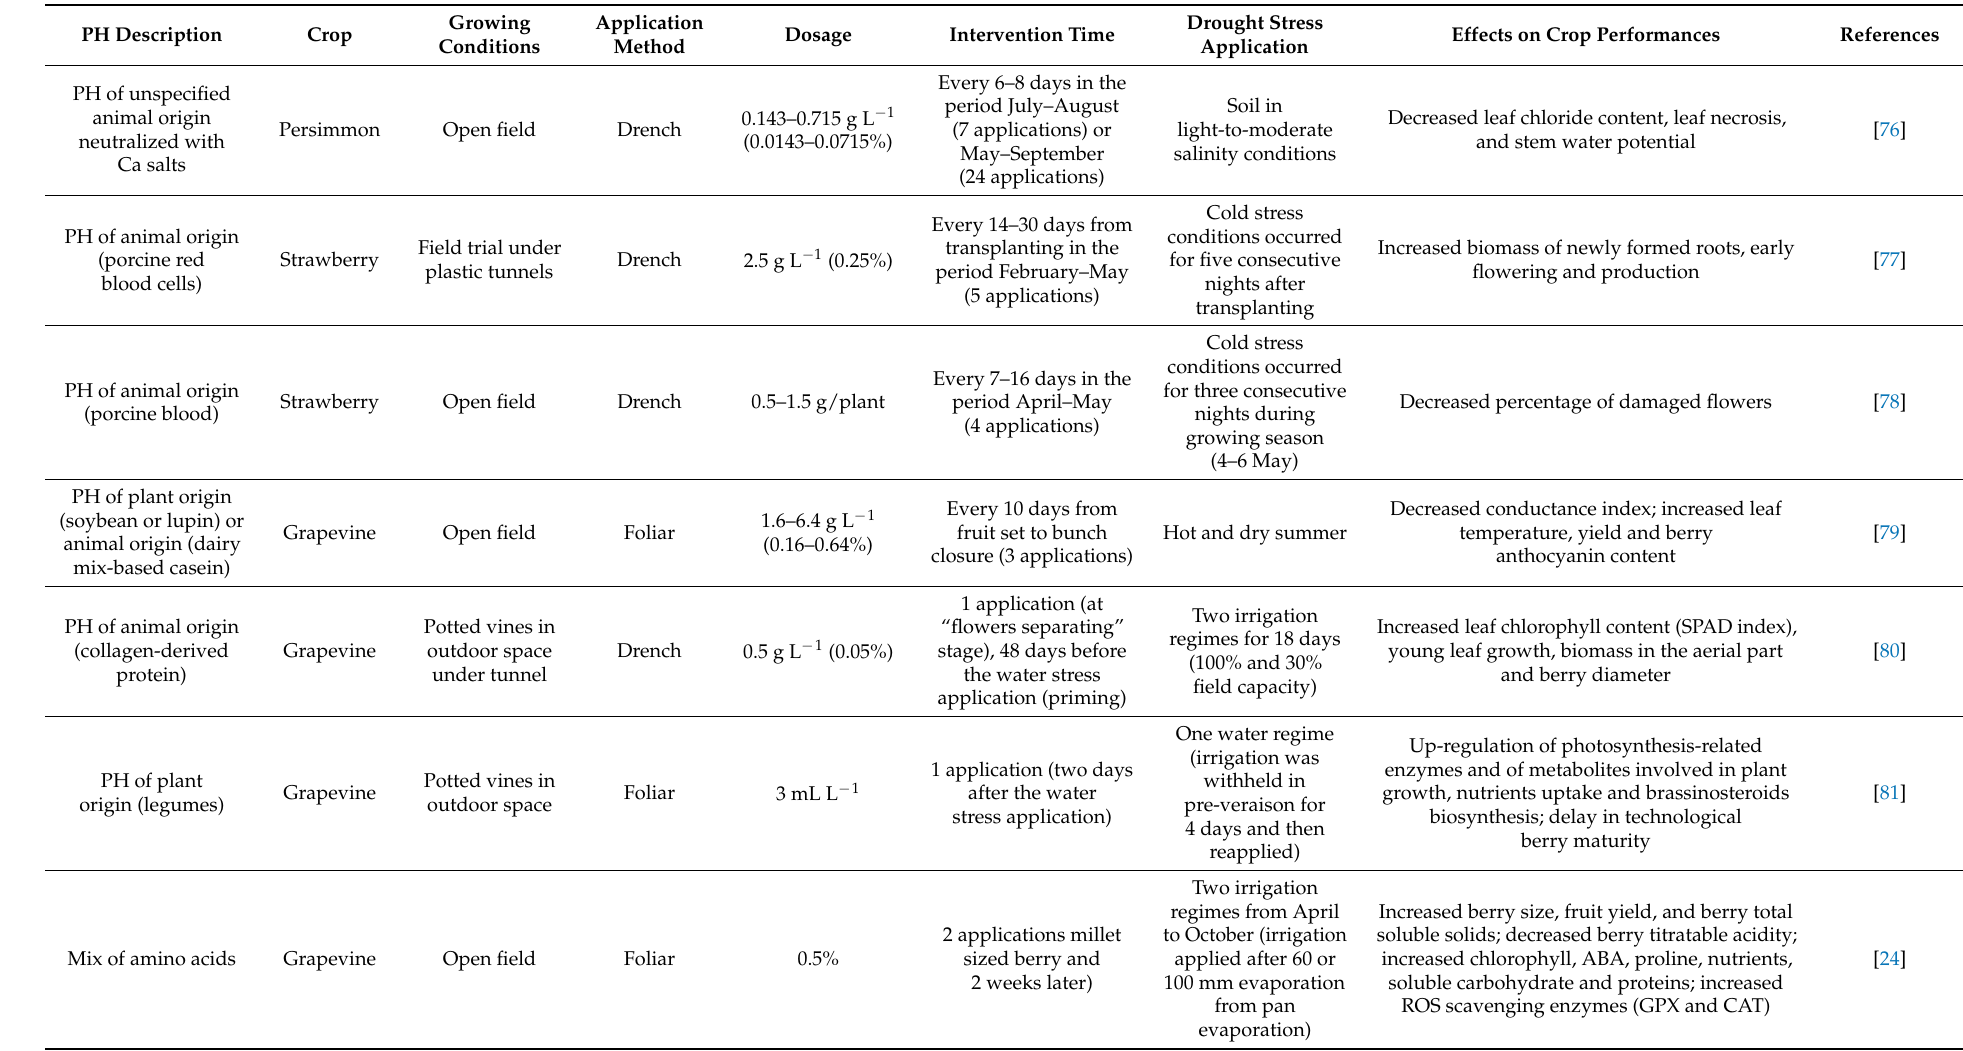
Table 7. Protein hydrolysate (PH) application methods to increase tolerance toward drought, salinity and thermal